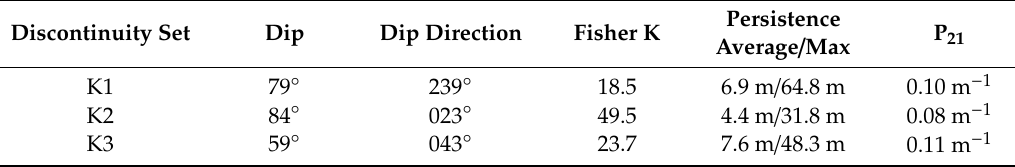
Table 1. Discontinuity sets included in the investigated DFN (from